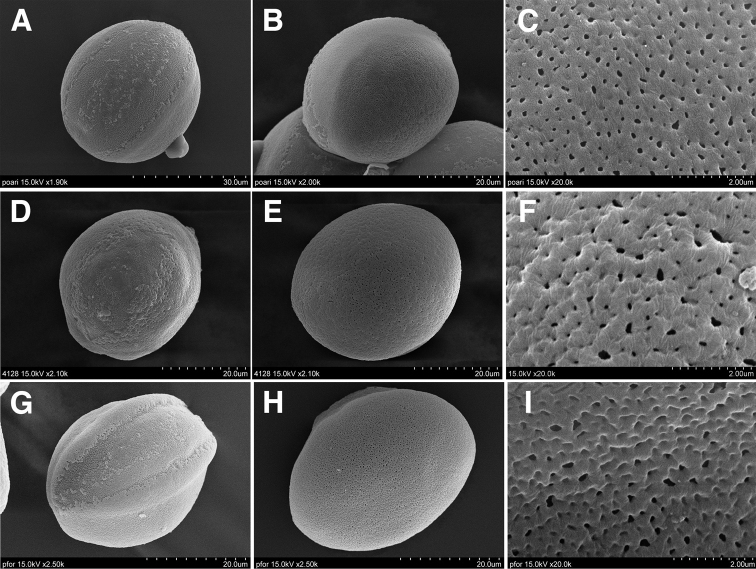
Pollen morphology of Polygonatum of Taiwan. A–CP.arisanensevar.arisanenseD–EP.arisanensevar.chingshuishanianumG–IP.arisanensevar.formosanumA, D, G proximal polar view B, E, H distal polar view C, F, I sculpture.